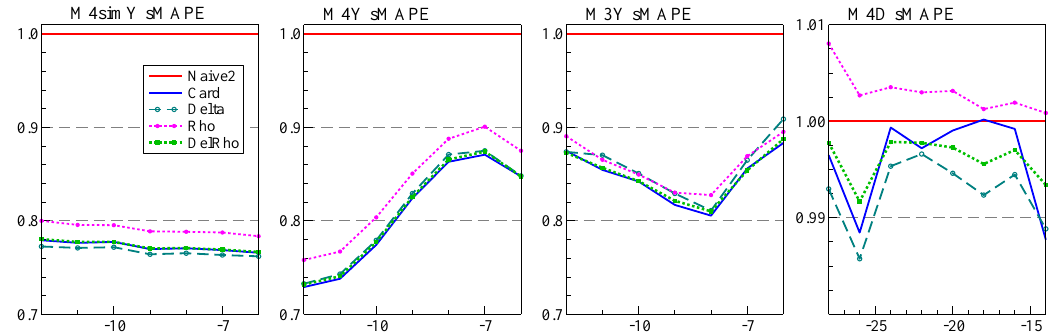
Figure 9. H -step sMAPE relative to that of Naive2 for all non-seasonal data (simulated, M4, M3, daily M4), retaining from 2 H to H observations for evaluation. Forecast methods are Delta , Rho , ( Delta + Rho ) /2, Card .